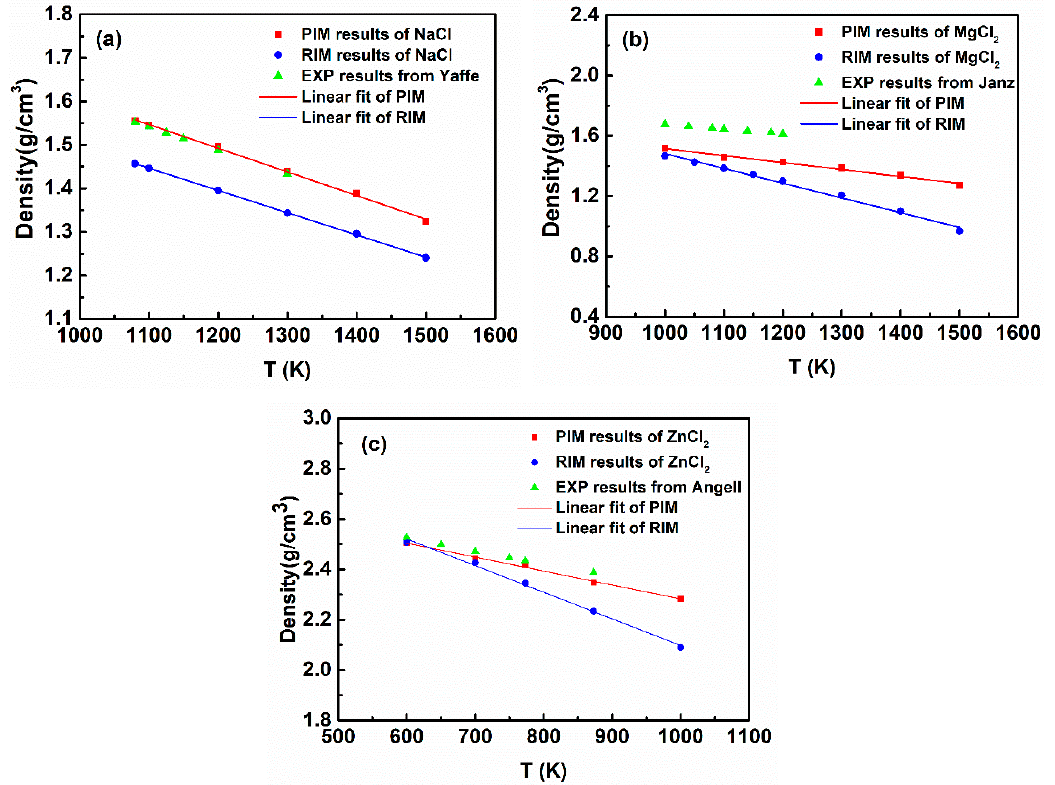
Figure 5. Simulated and experimental density results of molten chloride salts. ( a ) NaCl; ( b ) MgCl 2 ; ( c ) ZnCl 2 . Table 6. Densities of molten chloride salts in experiment and simulation